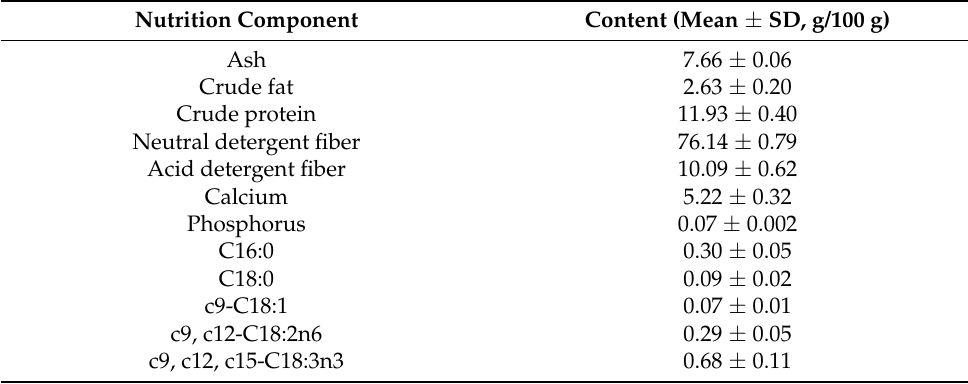
Table 1. The common nutrition and main fatty acid content of grass (dry